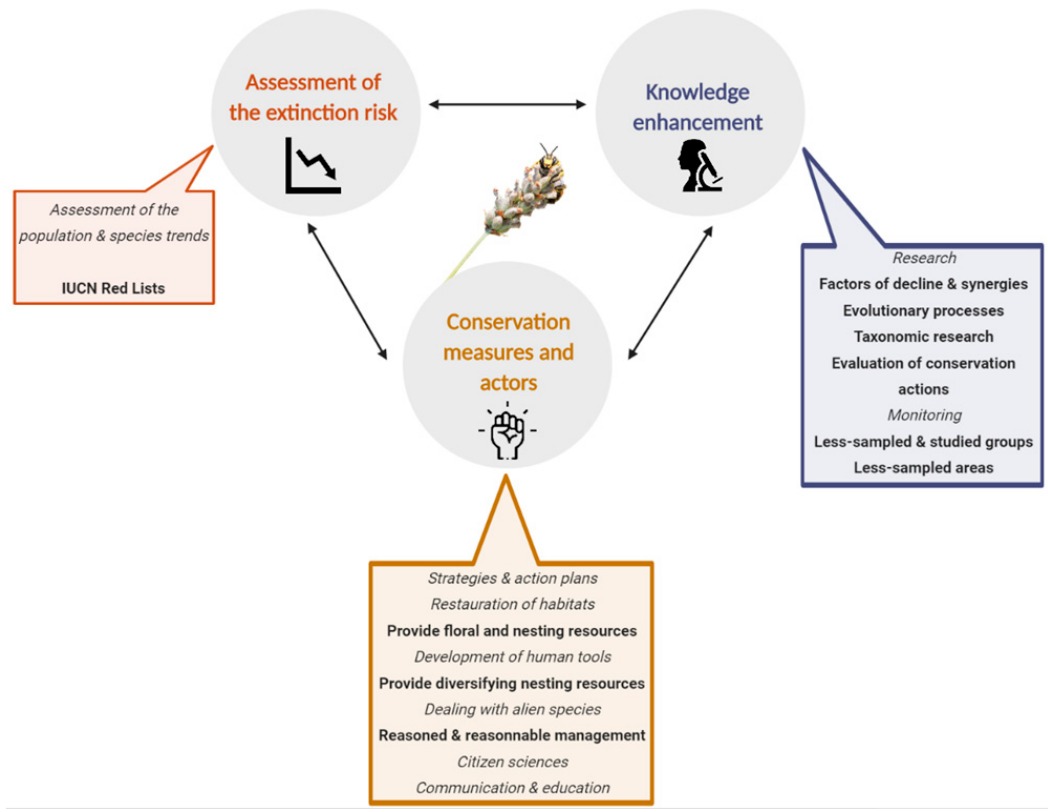
Figure 2. Virtuous circle of a conservation scheme implying to undertake simultaneously these distinct three steps. Icon made by Freepik perfect from www.flaticon.com.